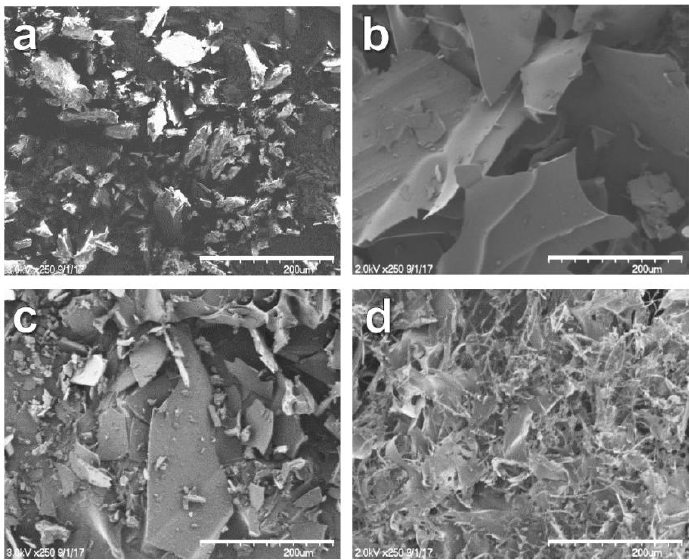
Figure 8. SEM images of ( a ) FT; ( b ) HP-β-CD-ol; ( c ) PM; and ( d ) IC. (×250 magnification, bar = 200 μm).